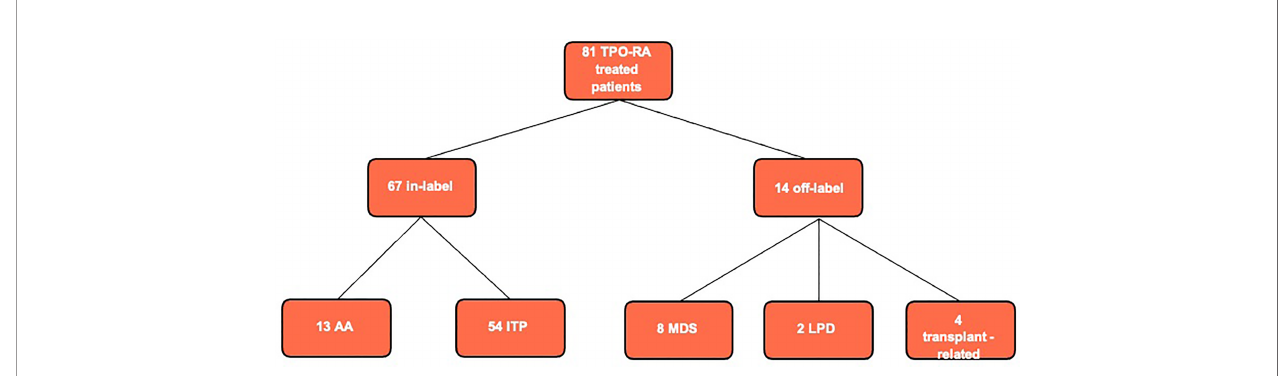
FIGURE 1 | Flowchart of thrombopoietin receptor agonist (TPO-RA) treated patients at our center in the last 10 years. Aplastic anemia (AA) refers to aplastic anemia patients treated in second line after failure of immunosuppressive therapy as for current drug indications; we had no off-label AA patient treated in fi rst line. MDS, myelodysplastic syndrome; LPD, lymphoproliferative disease; ITP, TABLE 1 | Patient outcome strati fi ed by group. PATIENT ID